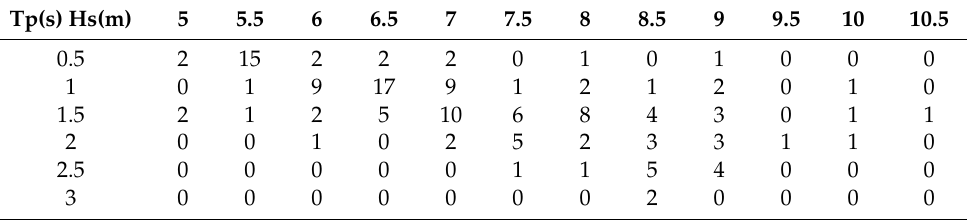
Table 6. Example of the number of occurrences for each sea state (monthly average) for a point in the Atlantic region of